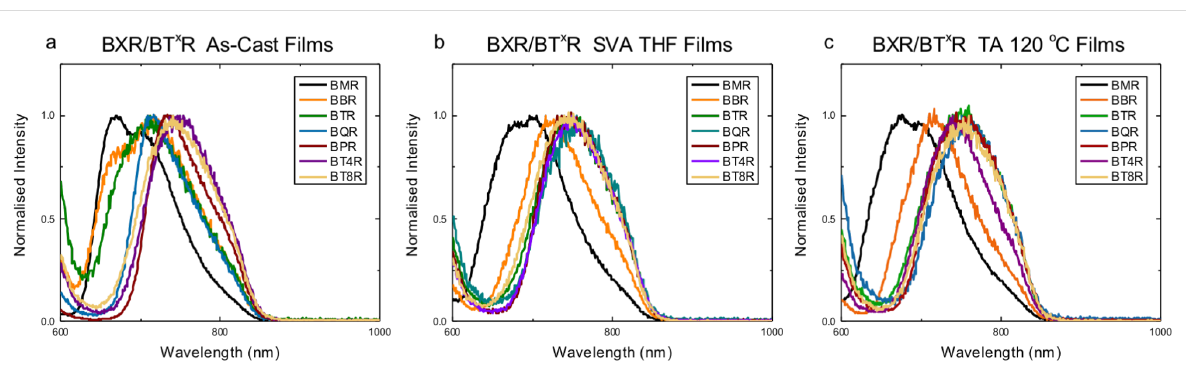
metric emission band is seen for all materials, except BMR and BBR , located at around 750 nm with a broad shoulder indicat- ing a secondary emission located at around 810–825 nm. For TA films, there is little change in the emission from that seen for SVA films indicating that under these conditions a similar underlying structure is formed after solvent vapour or thermal